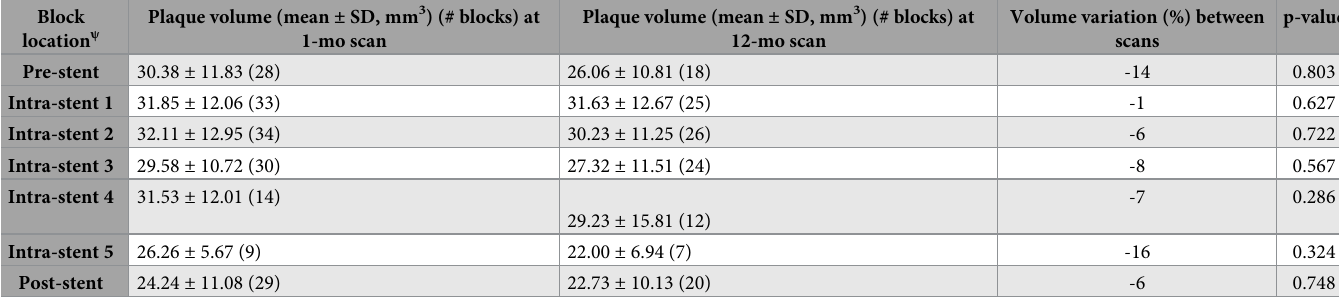
Table 6. Plaque volume at 1- and 12-month follow-ups by block location (pre-, intra 1-, 2-, 3-, 4-, 5-, and post-stent blocks). Block location ψ